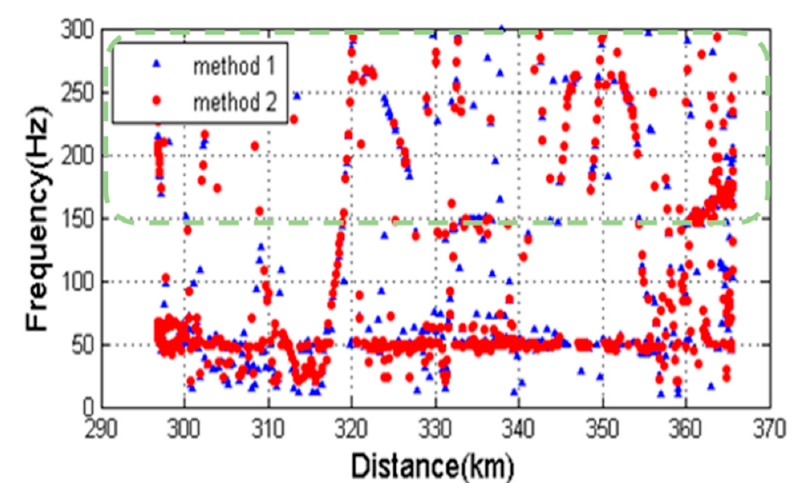
Figure 4. The frequency analysis of vibration acceleration on the axle with the train traveled position (Distance), which was indicated by the number of kilometers of distance away from the starting point of the track: The vibration acceleration value is shown in the range of 300 Hz or less in the case of the